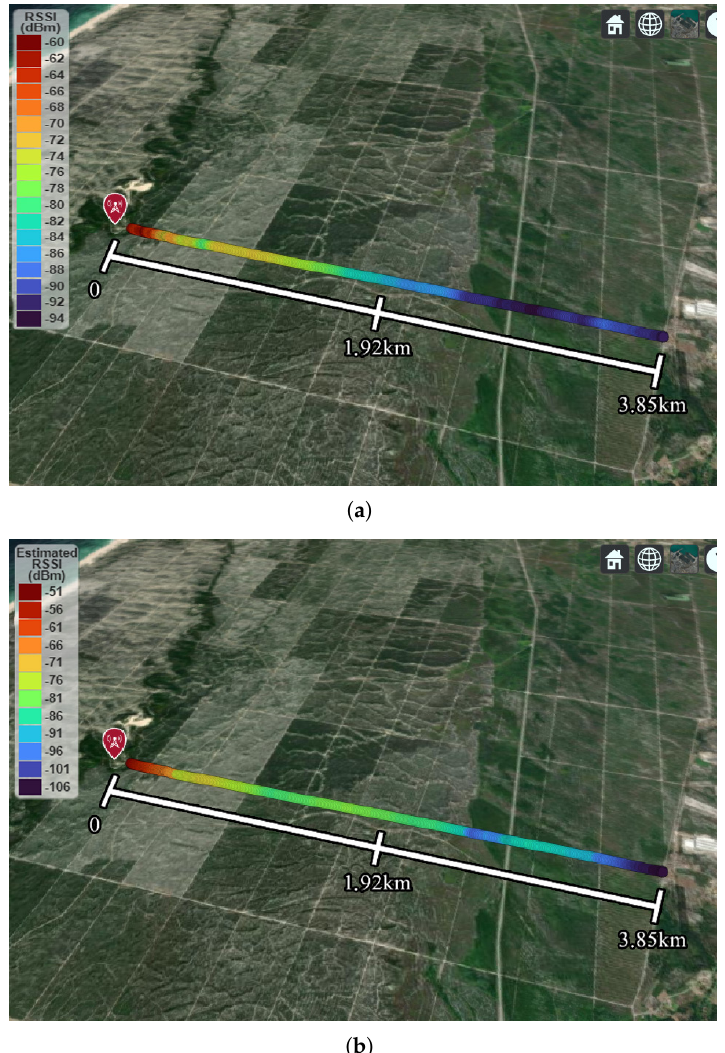
Figure 16. Maximum range campaign: ( a ) measured RSSI and ( b ) estimated RSSI using ITM radio propagation model of the proposed